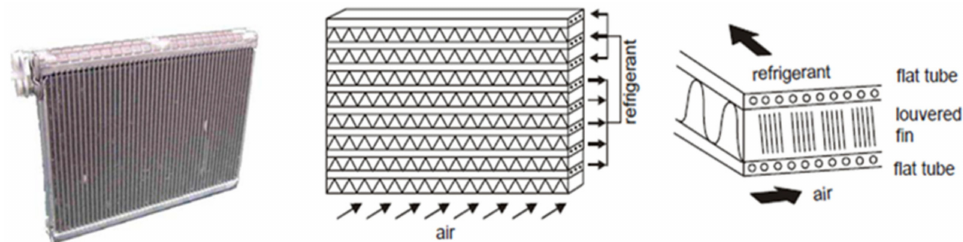
Figure 3. Evaporator picture ( left) and schematic of fluid flow ( middle , right ). Source: Limperich, Braun, Schmitz and Prölß. System Simulation of Automotive Refrigeration Cycles. Proceedings of the Fourth International Modelica Conference, Hamburg–Harburg, 2015, pp. 193–99 [49].